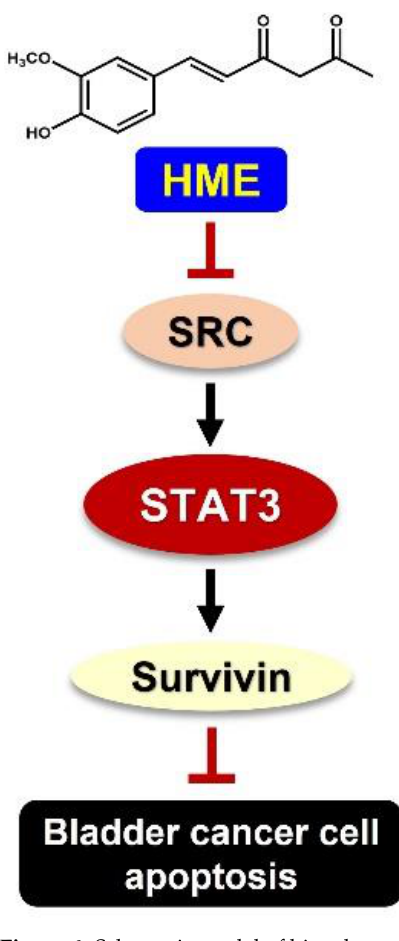
Figure 6. Schematic model of hispolon methyl ether (HME)-elicited anti-bladder cancer effect and the underlying mechanism of action based on the findings of this study. Briefly, HME induces cytotoxicity against bladder cancer cells by inducing apoptotic cell death by suppressing the antiapoptotic SRC/STAT3/survivin signaling pathway.